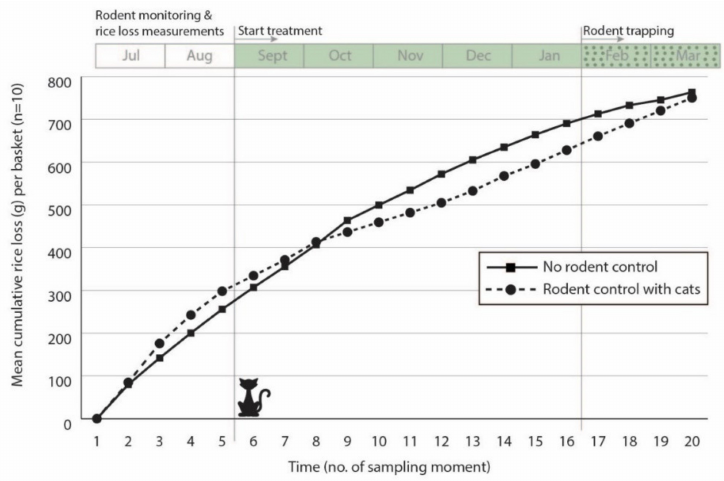
Figure 11. Fortnightly measurements of the cumulative weight loss (g) of stored rice removed by rodents from baskets placed in two rice mills (one without rodent control and one with rodent control by cats) from July 2016 to March